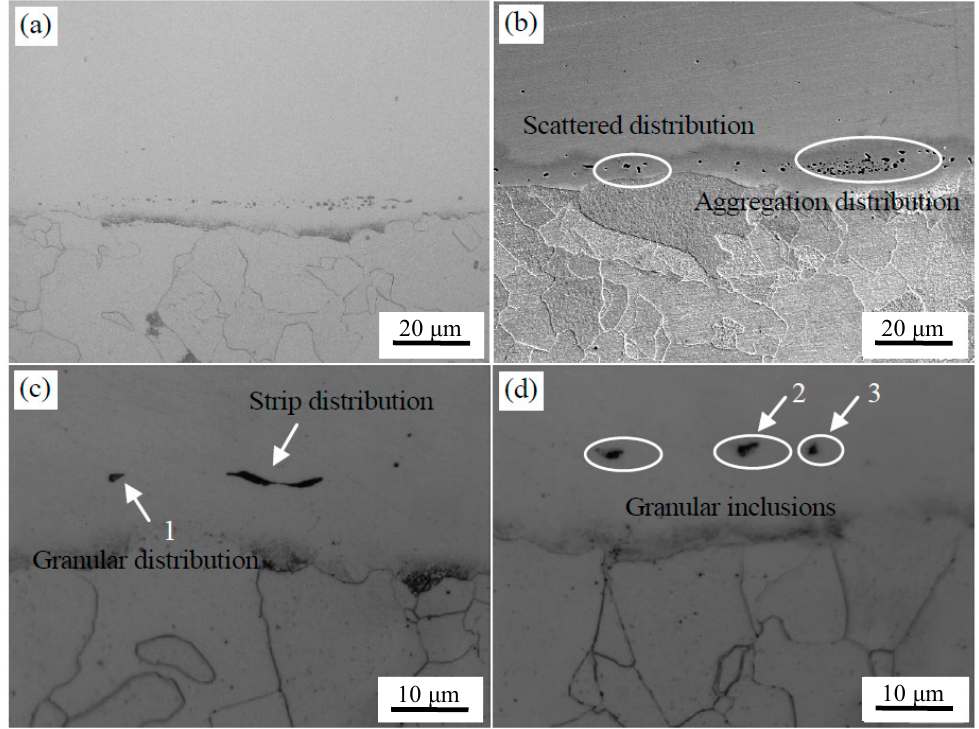
Figure 8. Microstructure of stainless steel clad plate with two treatments after hot rolling experiment. After brush grinding: ( a ) metallographic photo and ( b ) SEM. After pickling treatment: ( c ) metallographic photo and ( d ) SEM.